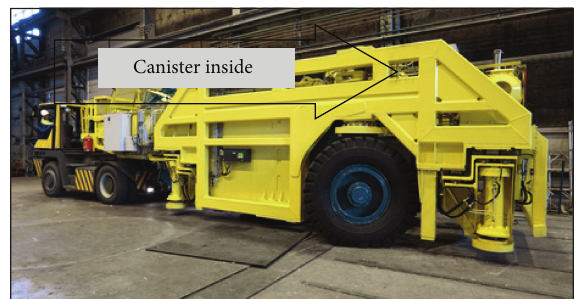
Figure 16: A prototype of a canister transferring and installation vehicle